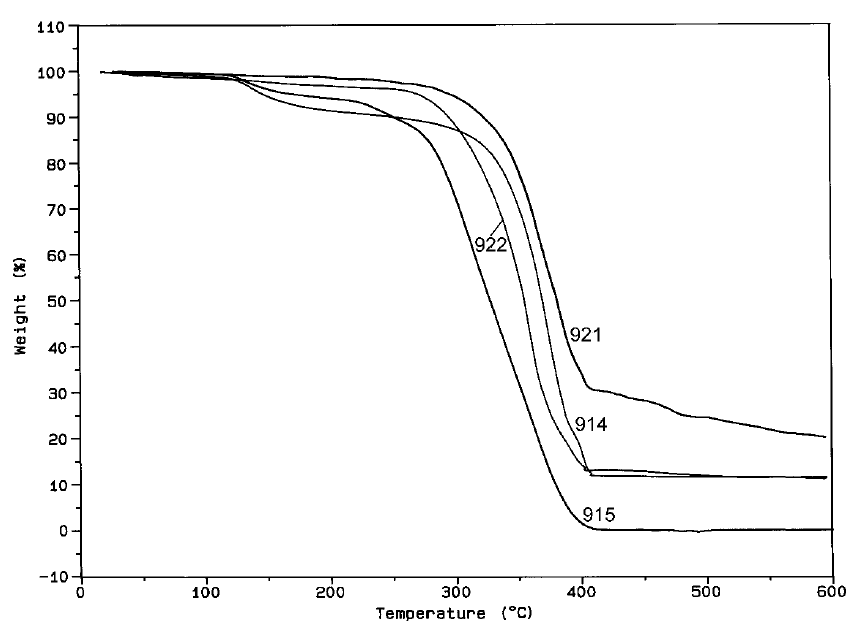
Fig. 2 TGA diagram of products with PMMA (s.915: PMMA; s.914:PMMA+TIP; s.921: PMMA+TIP+VTES; s.922: PMMA+TIP+OTES).